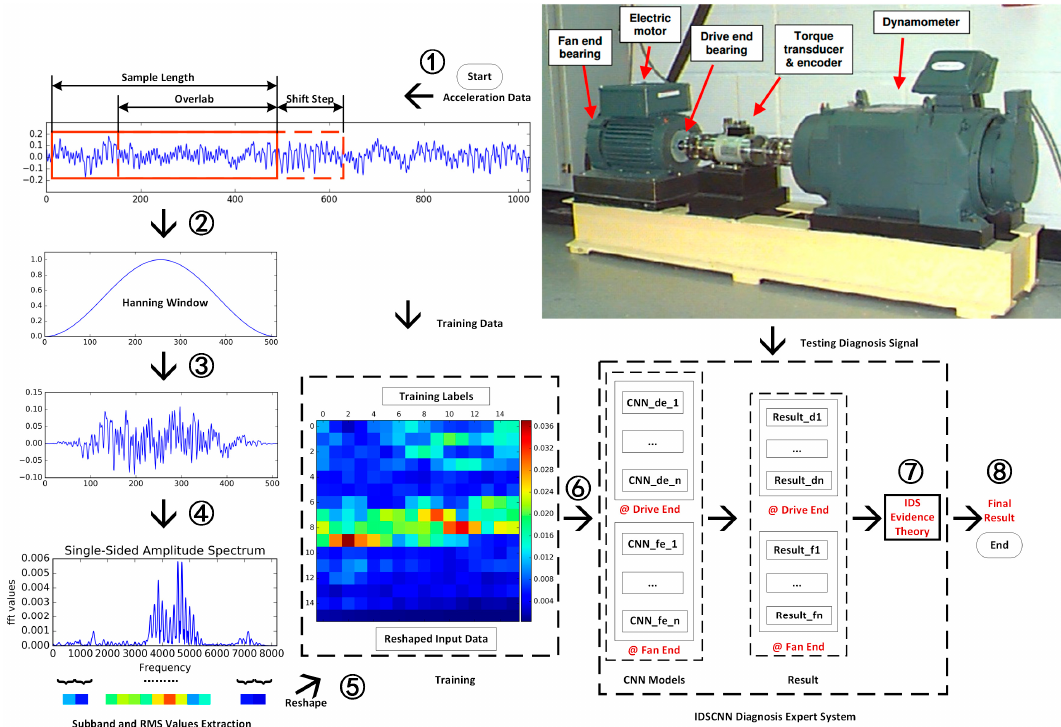
Figure 2. Flowchart of the IDSCNN based fault diagnosis.